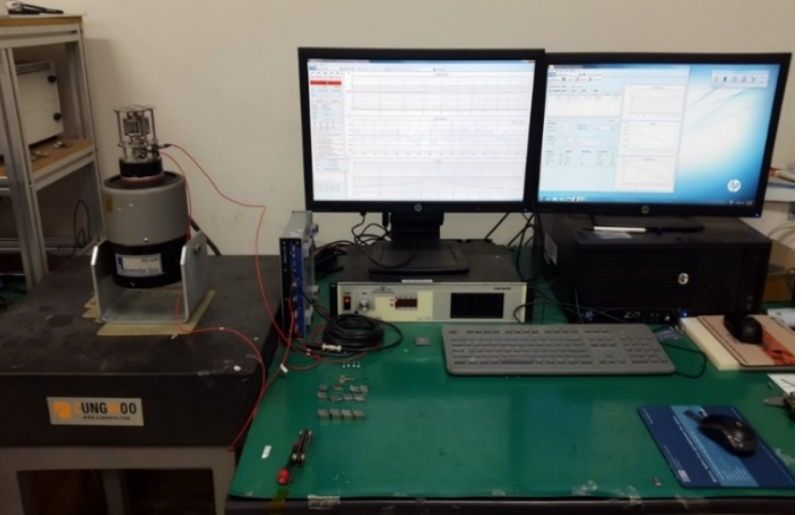
Figure 5. Measurement equipment and magnetic repulsive force tester on a vibrator for measuring the maximum force and resonance frequency. The repulsive force of the magnetic spring was measured according to the spacing between the magnets. As displayed in Figure 6, the repulsive force changed nonlinearly according to the spacing between the magnets: the smaller the spacing was, the more rapidly the repulsive force of the magnetic spring increased. Furthermore, as illustrated in Table 3, the difference in the repulsive force was large even when a small magnet was used. The repulsive force of the magnetic spring was over 100 N at a spacing of 3 mm in this study. The regression equation of the repulsive force is presented in Equation (2) according to the spacing between the magnets in this study (size: outer diameter, 25 mm; inner diameter, 10 mm; thickness, 7 mm):